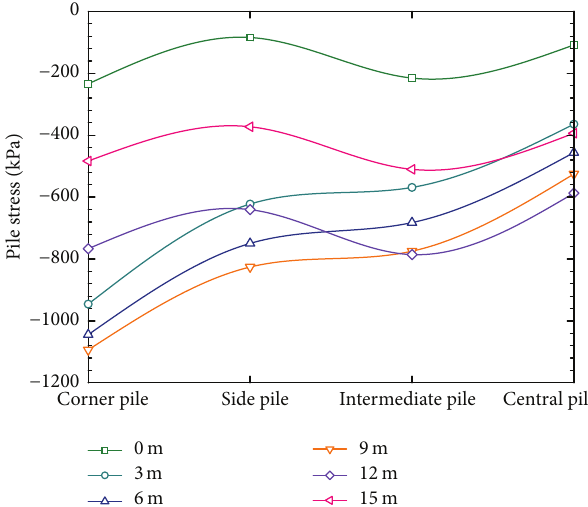
Figure 12: Distribution of the CFG piles stress with pile positions.